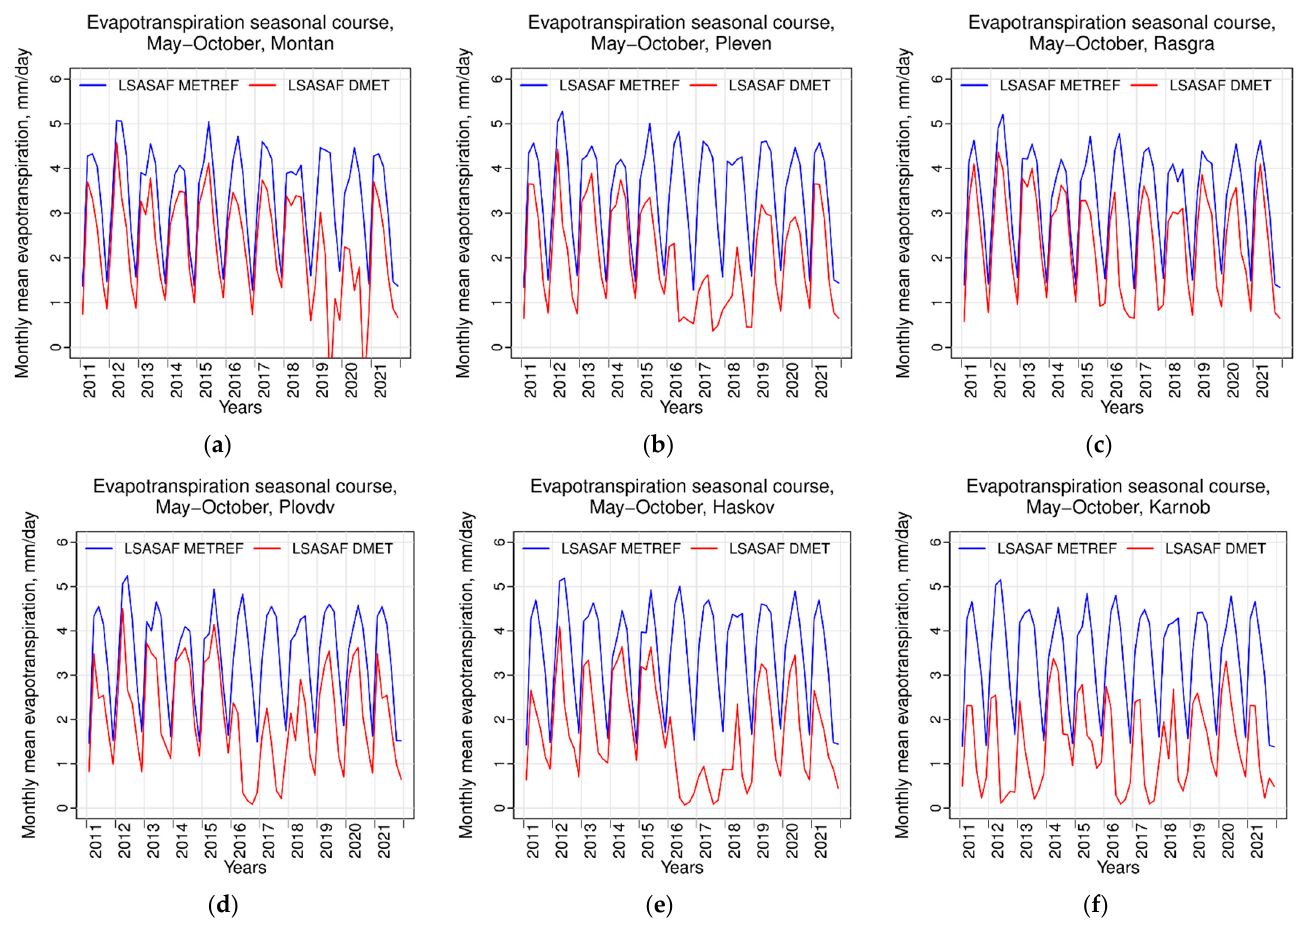
Figure 3. Comparison of monthly means (May-October, 2011–2021) for potential evapotranspiration (LSASAF METREF, blue) and actual evapotranspiration (LSASAF DMET, red) for selected synoptic stations in: ( a – c ) north Bulgaria; ( d – f ) south Bulgaria.